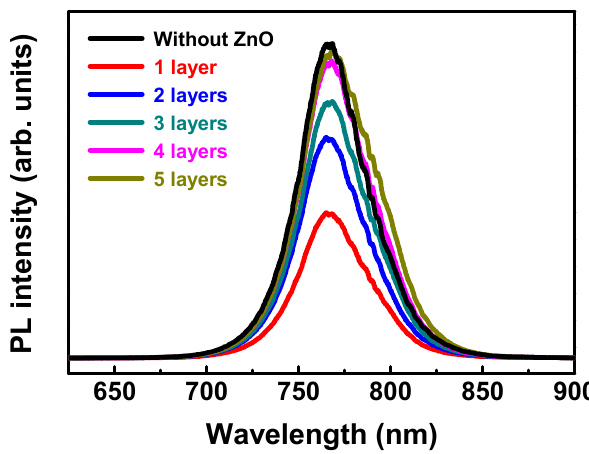
Figure 4. PL spectra of perovskite films with various ZnO electron transport layers on a bare glass substrate, baking at 180 °C.